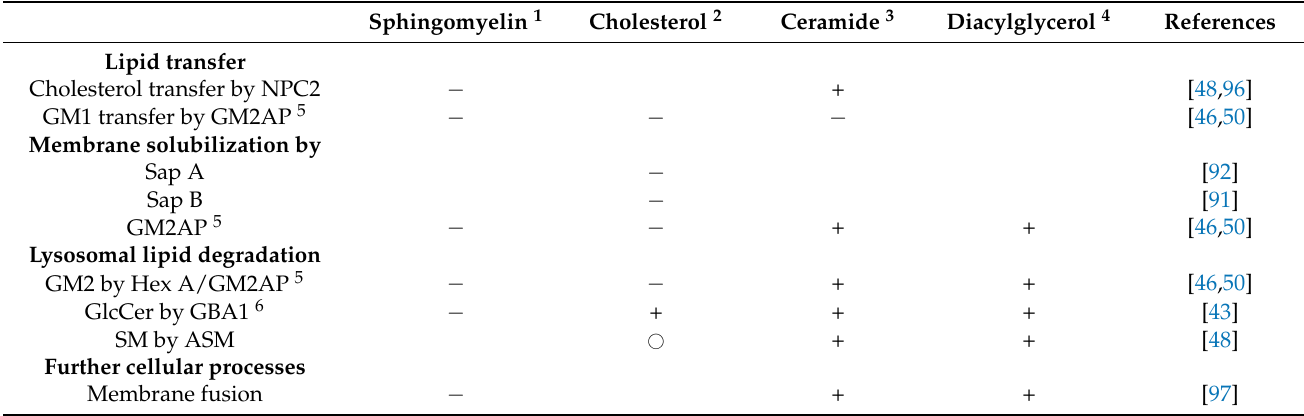
Table 2. Storage lipids (SM, cholesterol) in ASM deficiency and their hydrolysis products (ceramide, diacylglycerol) regulate cellular